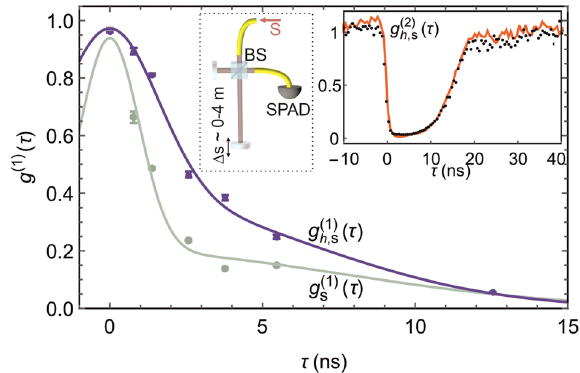
ð τ Þ of Fig. 2 Measurements of the fi rst degree of coherence g ð 1 Þ S ð τ Þ and of Stokes light. The coherence of heralded QNG light g ð 1 Þ h ; S unconditioned Stokes fi eld is shown as blue and gray plots, respectively. The solid curves correspond to the sum of a two Gaussian functions used for an effective quantitative evaluation of the temporal widths of the measured of g (1) ( τ ). The insets show ð τ Þ evaluated from its the heralded intensity correlation function g ð 2 Þ h ; S direct measurement as black data points and a scheme of Michelson interferometer with a tunable relative path difference Δ s covering expectable heralded Stokes temporal wavepackets on the order of ð τ Þ can be plausibly reproduced by ten ns. The measured g ð 2 Þ h ; S ð τ Þ and Stokes intensity simulation employing the measured g ð 2 Þ S ; AS ð τ Þ measurement in an pro fi le I S ( τ ) estimated from the g ð 2 Þ S unheralded regime, what suggests a close to unity overlap between the unconditioned and heralded temporal intensity functions of Stokes fi eld. Error bars correspond to a single standard deviation and, where not illustrated, their size is smaller than the size of the corresponding plot